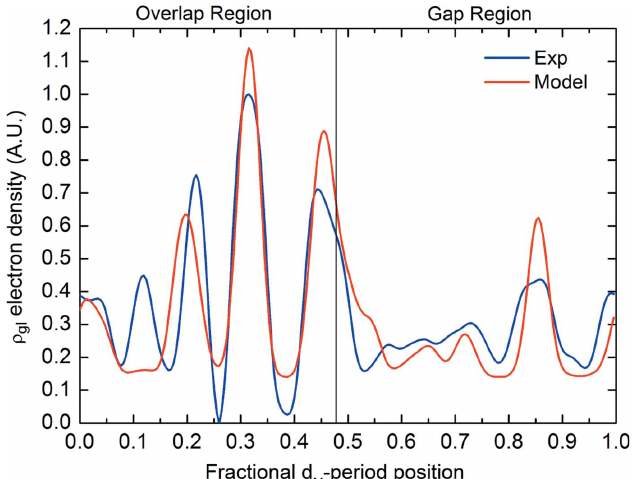
Figure 7 D arg–lys ( x ) function (red curve) versus (cid:4) gl obtained by the Fourier difference synthesis of the experimental SAXS data (blue curve) as a function of the fractional d M -period coordinate. Both functions were normalized to the same integral